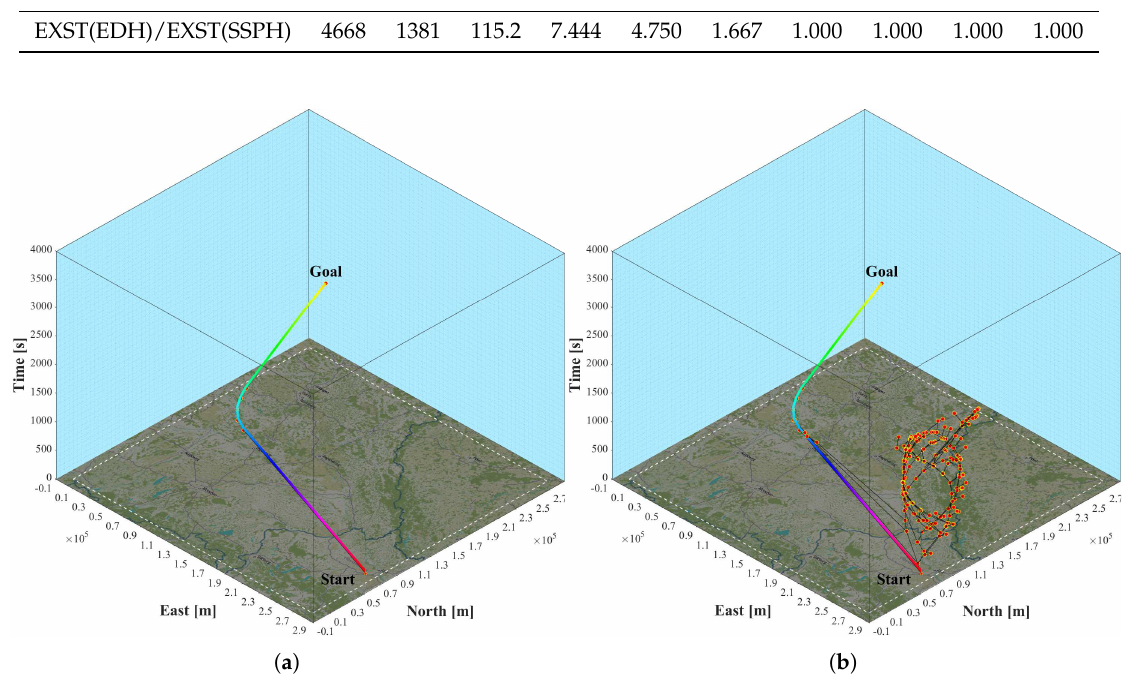
Figure 13. Comparison for the first MPTP iteration in Tables 14 and 15: candidate future states (yellow and red dots) in the Closed List using ( a ) A* with SSPH and ( b ) A* with EDH . Until the goal is reached, the A*-like algorithm incrementally generates ramifications in the X -space all rooted in the start state.